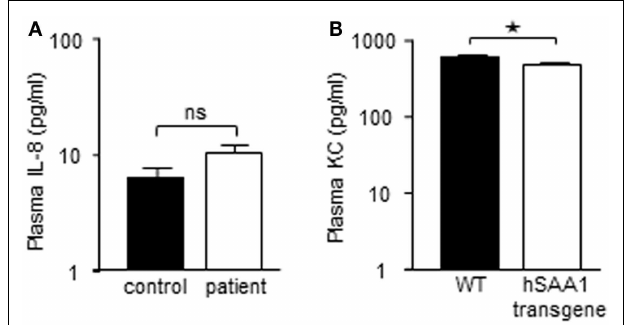
controls (black bar) were evaluated for IL-8 content using a Luminex analysis; shown is mean ( + SEM). (B) WT and transgenic mice expressing human SAA1 in adipocytes were fed a high-fat diet to induce obesity. Obese transgenic mice have circulating levels of human SAA1 similar to the levels seen in human obesity. Plasma samples were analyzed by ELISA for the murine IL-8 counterpart CXCL1/KC and are shown as mean ( + SEM;WT mice; n = 10 black bar, transgenic mice; n = 8, white bar). Statistical analyses were performed using unpaired t -tests (* p < 0. 05; ns, not